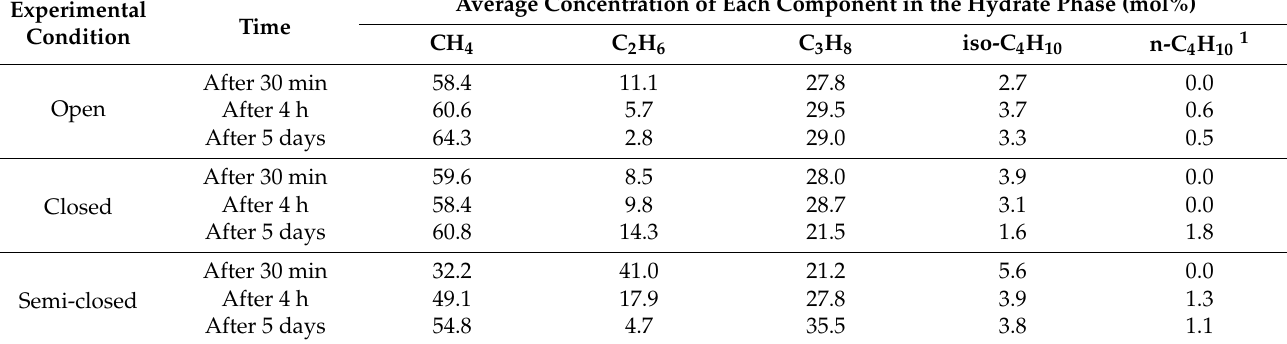
Table 2. Average composition of the hydrate phase formed under different gas supply conditions. Experimental